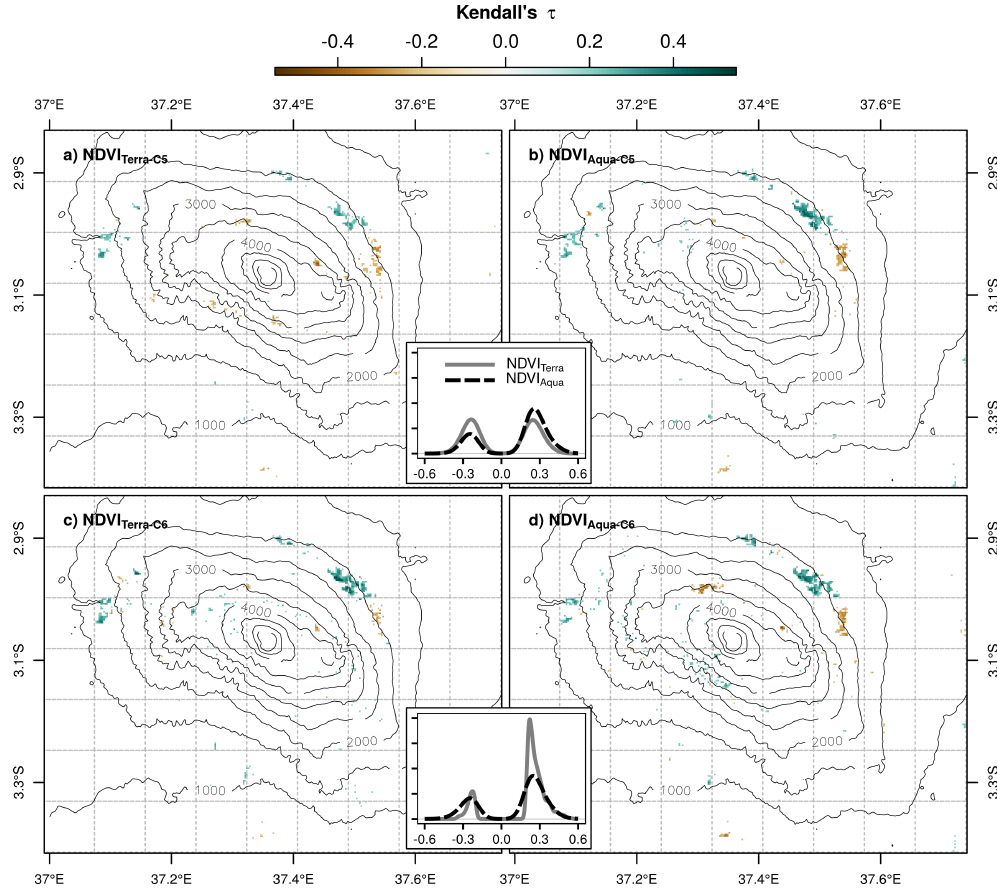
Figure 4. Spatial patterns of “conclusive” values of τ (2003–2012) for ( a ) NDVI Terra-C5 ; ( b ) NDVI Aqua-C5 ; ( c ) NDVI Terra-C6 ; and ( d ) NDVI Aqua-C6 . Also included are the 1-d Kernel density estimates for the 250-m MODIS products originating from Collections 5 (connecting a and b ) and 6 (connecting c and d ). The underlying CRS and additional data are the same as in Figure 1.